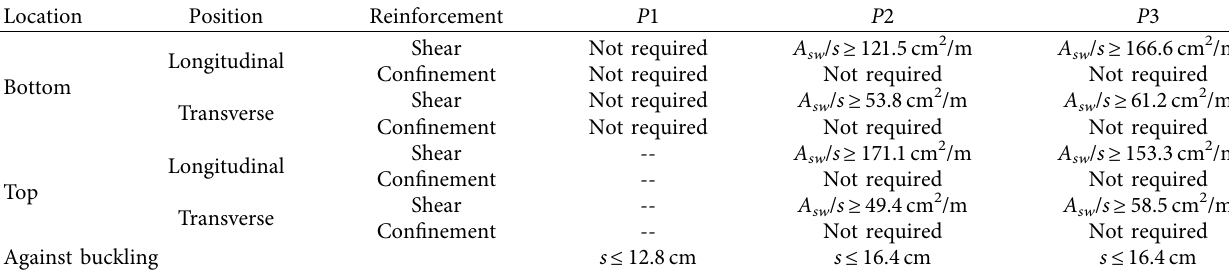
Table 5: Suggested transverse reinforcements of